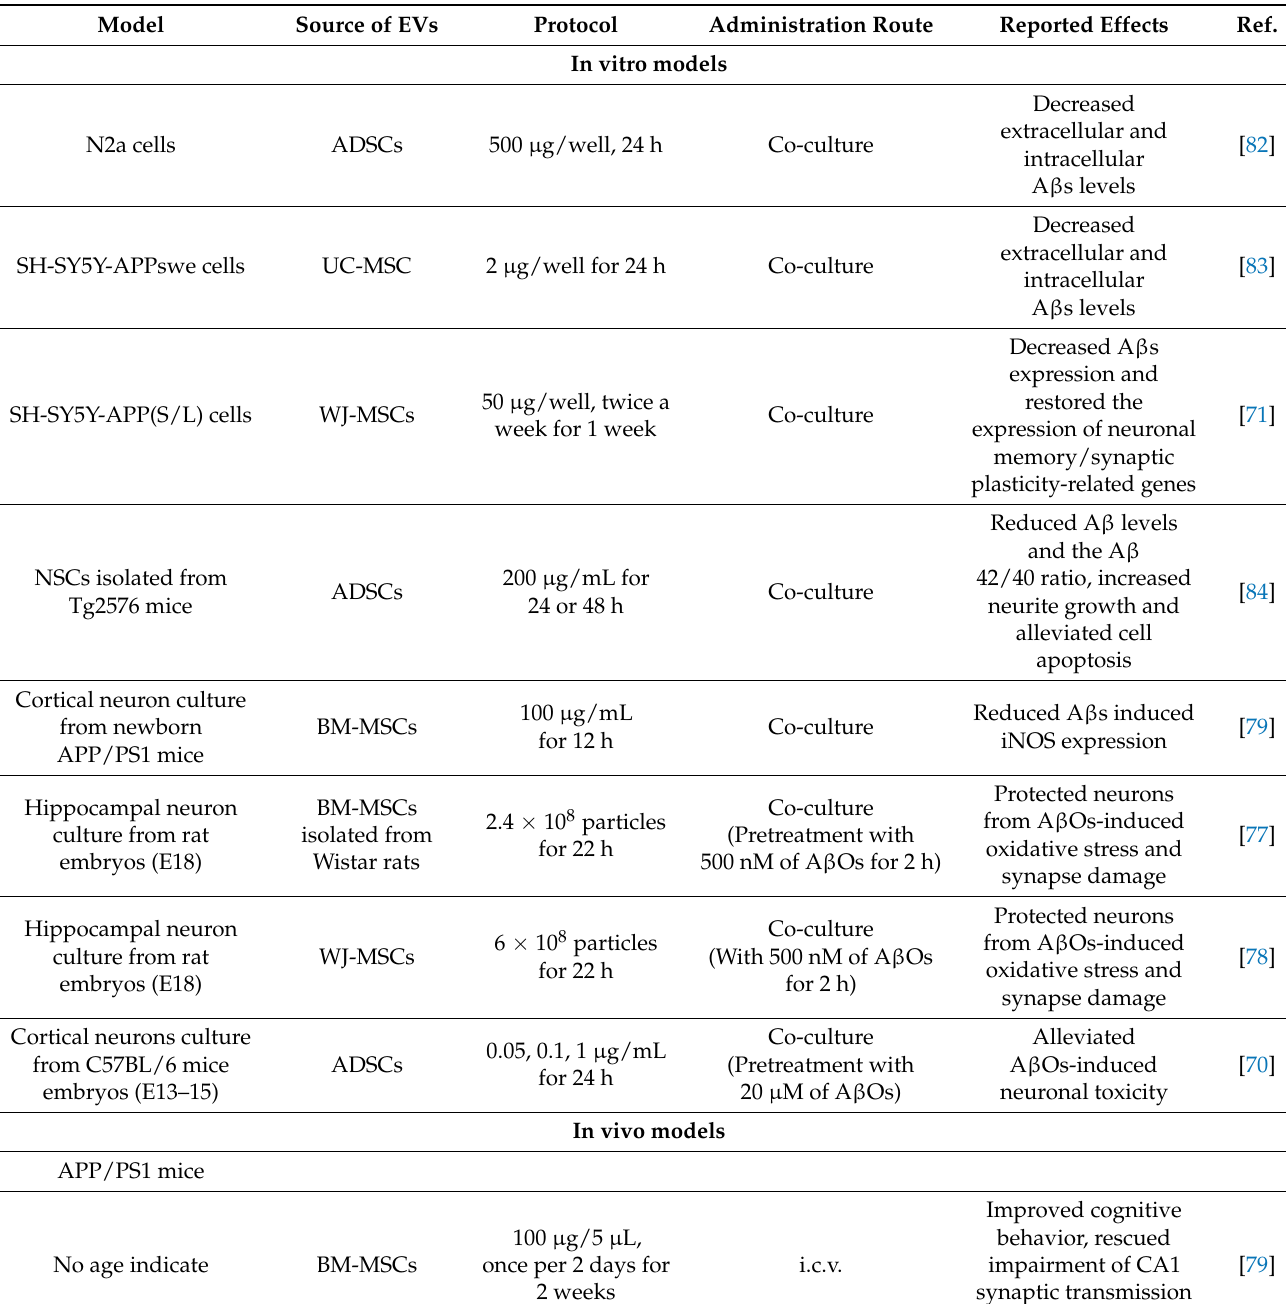
Table 1. A summary of preclinical studies of MSC-derived EVs-based therapy both in vitro and in vivo models of AD. Model Source of EVs